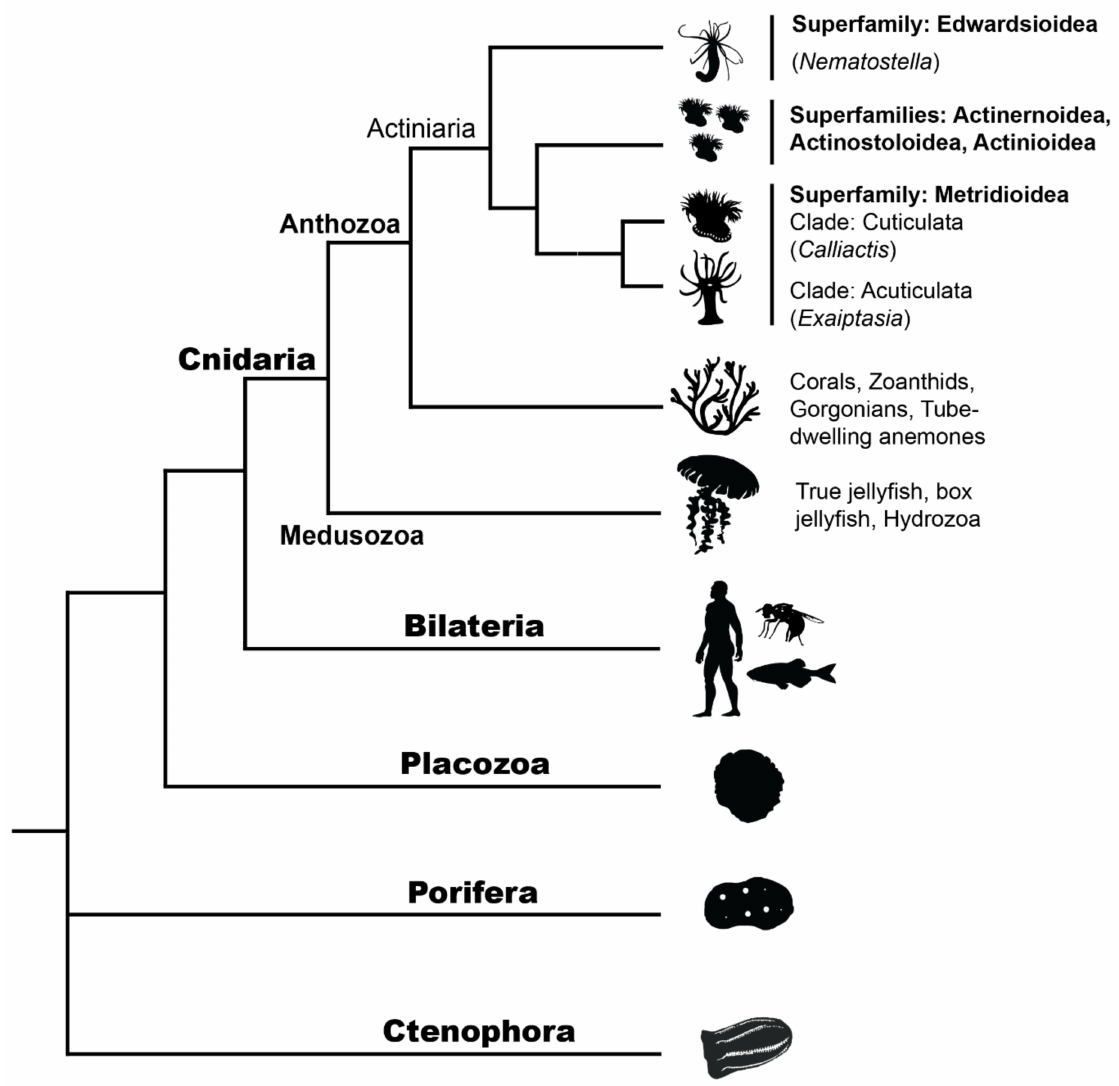
Figure 3. Metazoan phylogeny shows the phylogenetic placement of Cnidarians, including the two major classes within Cnidaria: Medusozoa (e.g., jellyfish, hydrozoans) and Anthozoa (e.g., corals, sea anemones). All non-actiniarian Anthozoans are shown as a single branch for visual simplicity. Internal branches within the order Actiniaria show where Nematostella, Exaiptasia and Calliactis species sit within the superfamilies Edwardsioidea and Metridioidea. Actiniarian branches have been simplified here for visual purposes; however, Actiniaria is not monophyletic and there is conflict over current hierarchies, see [21]. See Supplementary File S1, Table S1 for image copyrights and